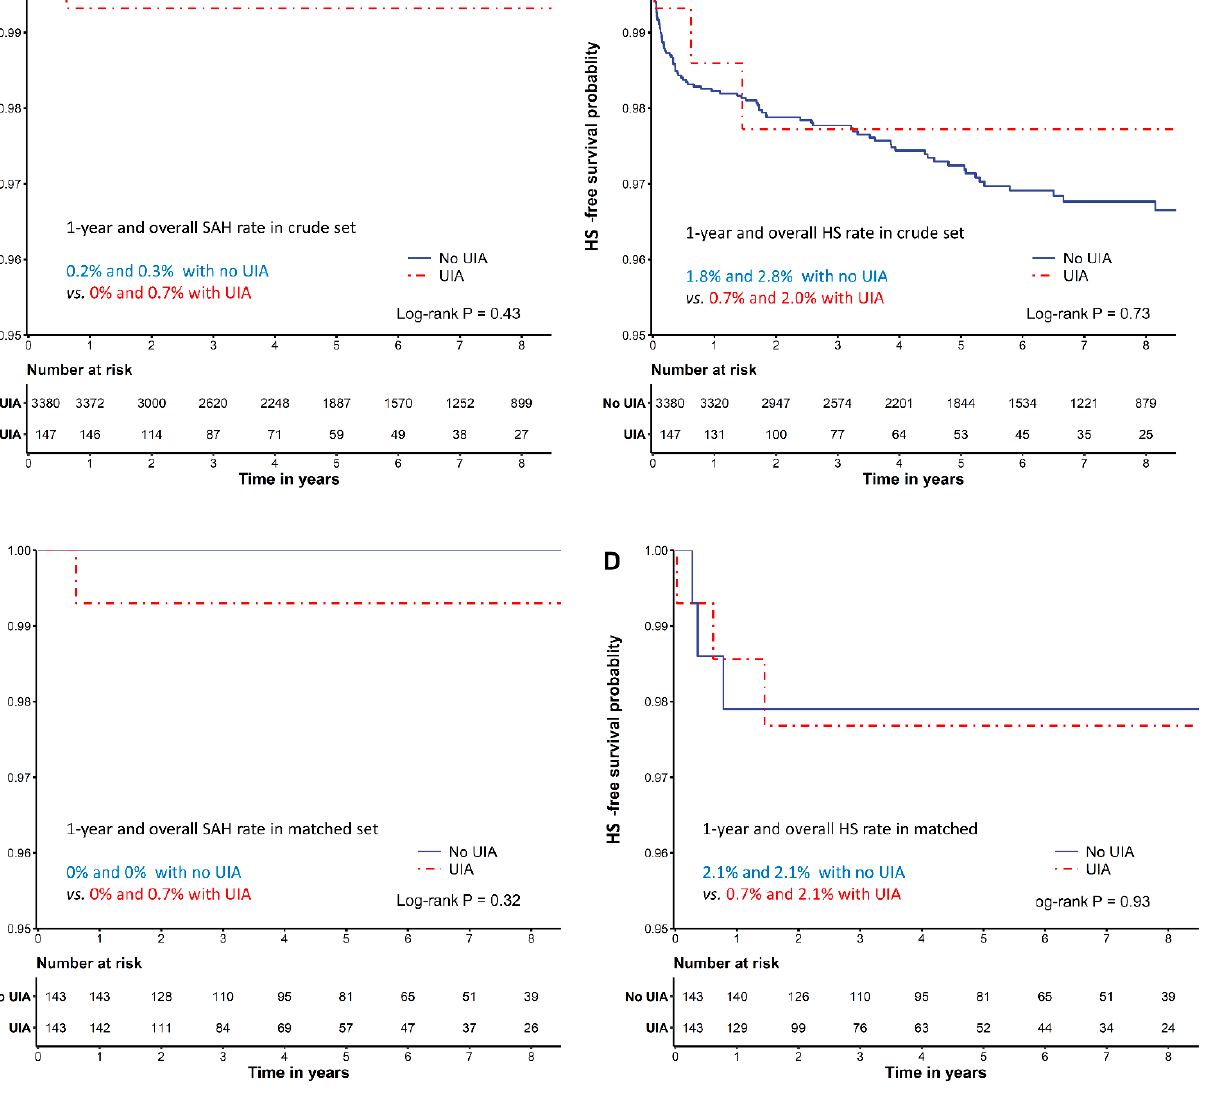
Figure 1. Kaplan–Meier curve showing cumulative ( A , C ) subarachnoid hemorrhage-free and ( B , D ) hemorrhagic stroke-free survival in crude ( A , B ) and propensity score-matched cohorts ( C , D ).